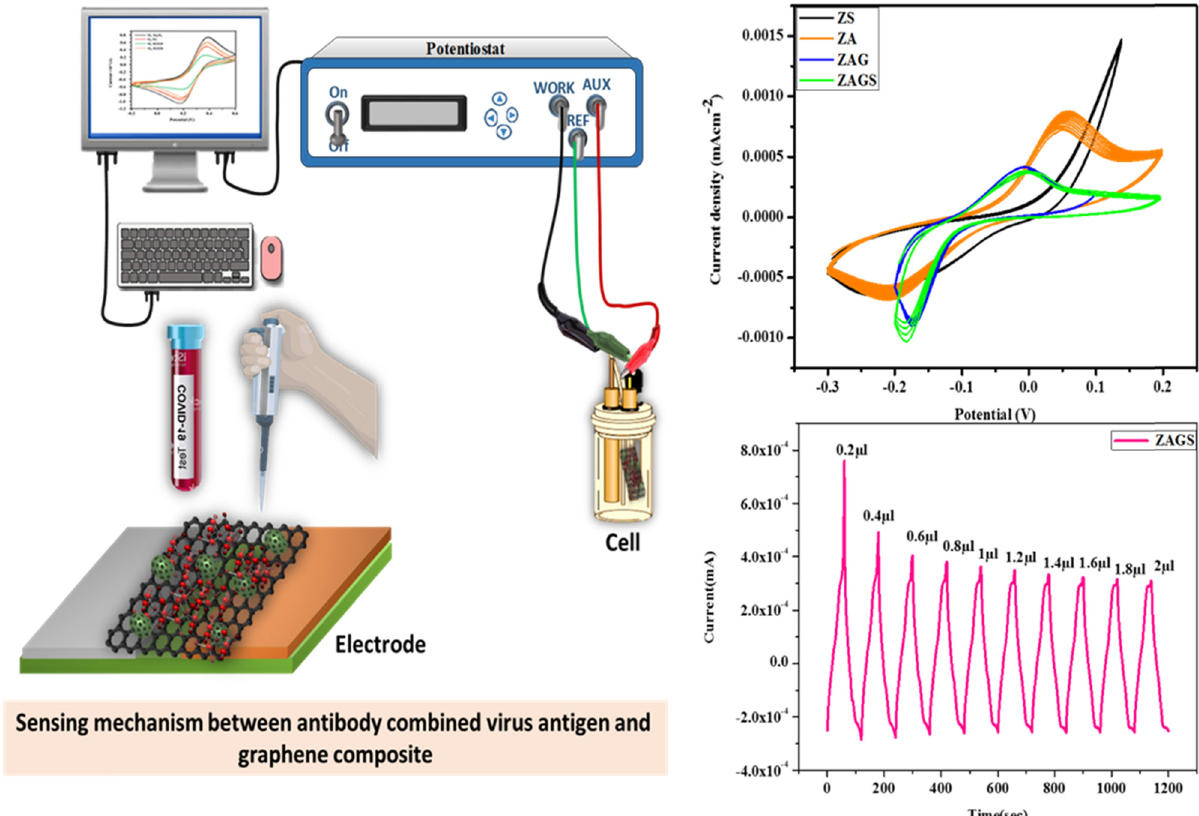
Figure 1: Graphene quaternary nanocomposite - based sensor and cv – iv